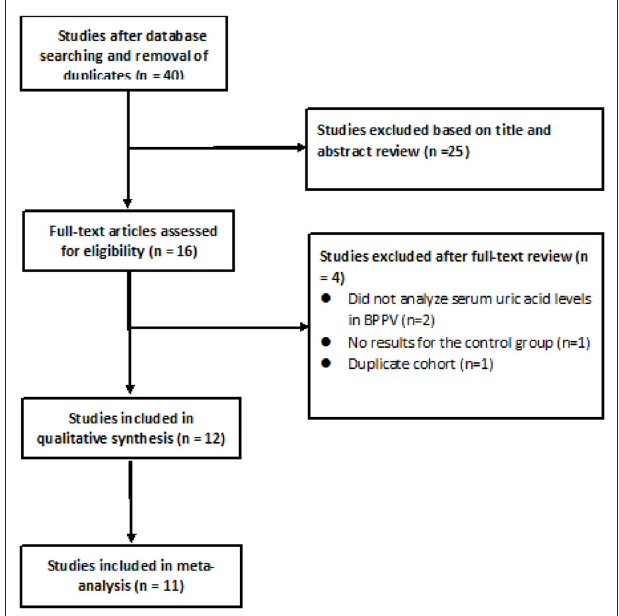
FIGURE 1 | Flow diagram of study